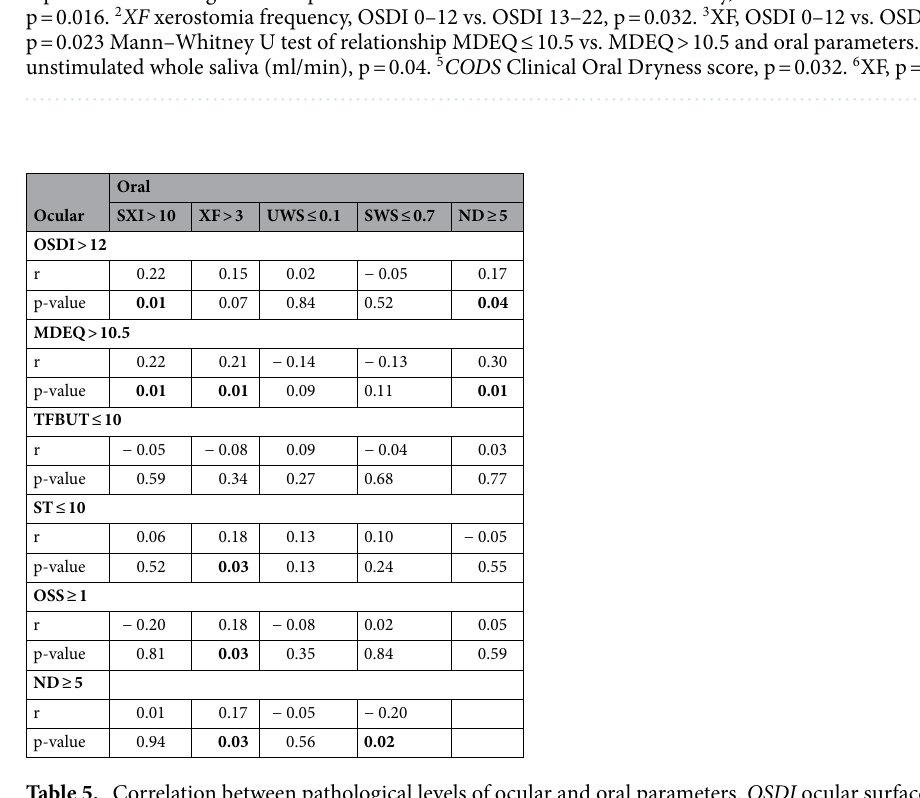
Table 5. Correlation between pathological levels of ocular and oral parameters. OSDI ocular surface disease index, MDEQ McMonnies Dry Eye Questionnaire, TFBUT tear film break-up time, ST Schirmer I Test (mm/5 min), OSS ocular surface staining, ND number of drugs, SXI summated xerostomia inventory, XF xerostomia frequency, UWS unstimulated whole saliva (mL/min), SWS stimulated whole saliva (mL/min). Bold values represent level of significance: p <